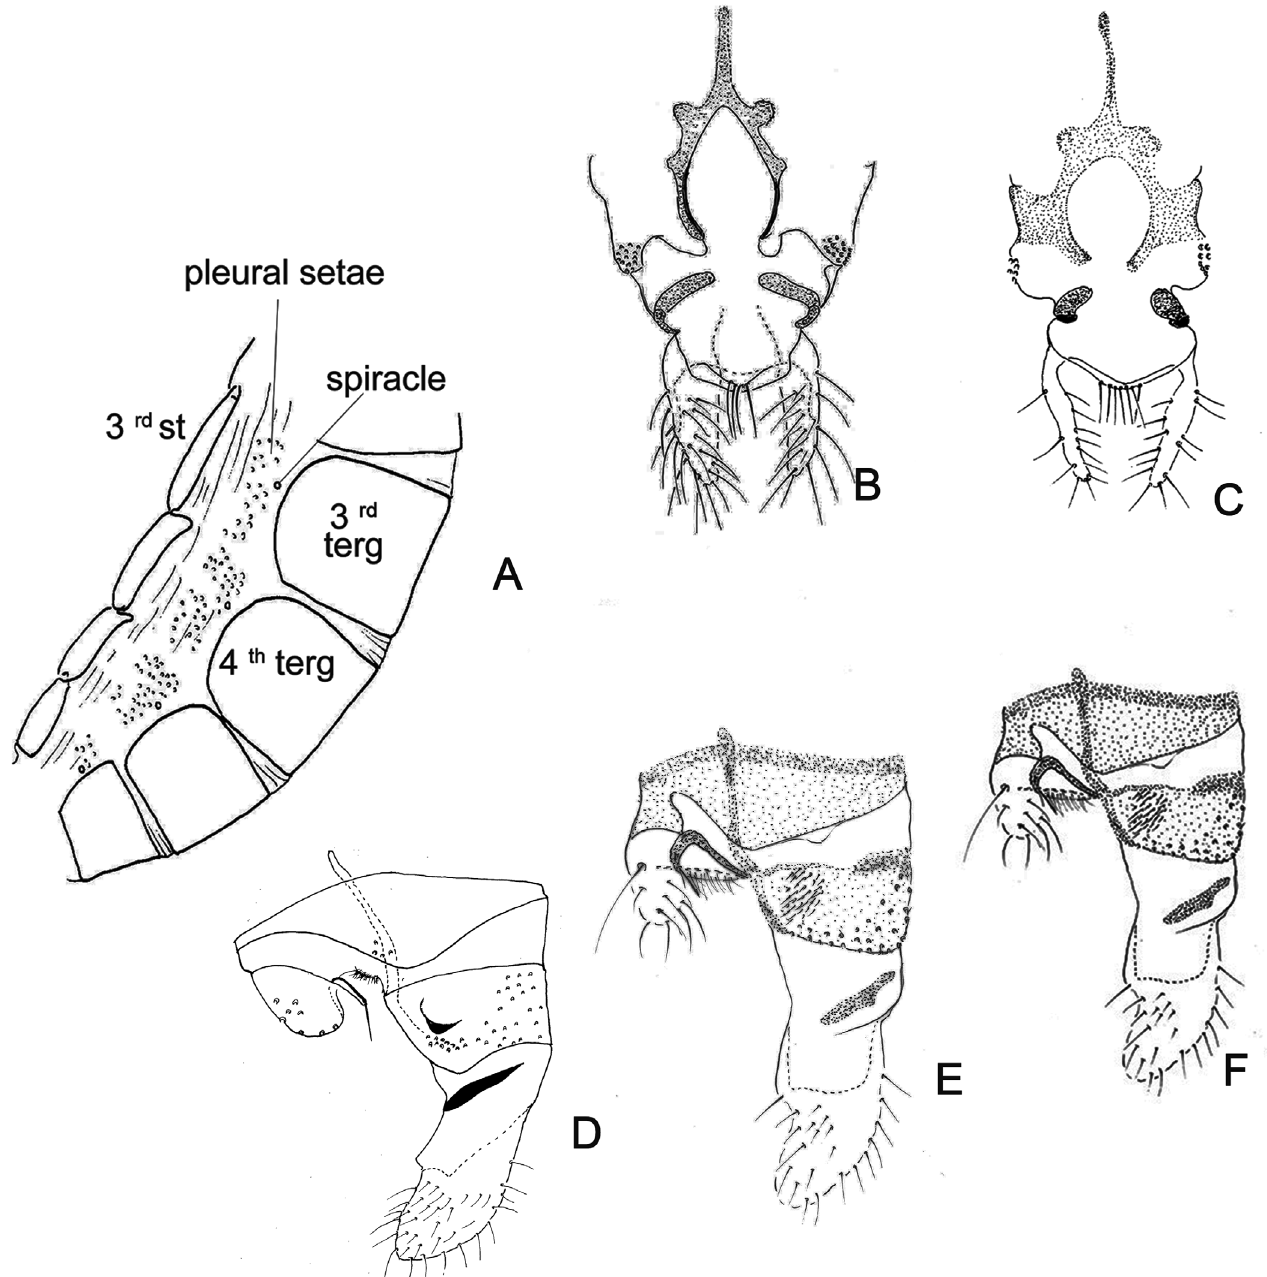
Figure 17. Some structures of the abdomen and the genitalia of phlebotomine females. (A) 3rd–6th abdominal segments showing the pleural setae: Lutzomyia ( Tricholateralis ) sherlocki. (B, C) 10th sternite showing non-deciduous setae in the median region: (B) Micropygomyia vexator , (C) Sergentomyia minuta . (D) 9th segment showing a sclerotized protuberance on the tergite: Migonemyia ( Migonemyia ) rabelloi , (E) spicules in 9th and 10th tergites: Lutzomyia ( Tricholateralis ) cruciata. (F) 9th tergite with short bristles: Sciopemyia sordellii